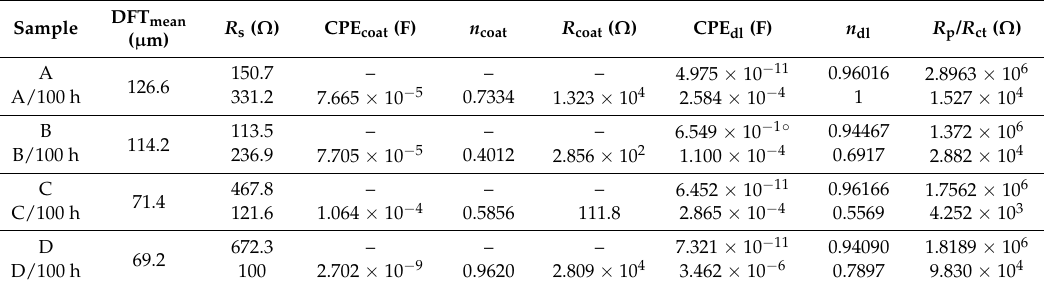
Table 5. The results of the EIS measurement at the begging (A, B, C, D) and after 100 h (A/100 h, B/100 h, C/100 h, D/100 h) immersion in 4% w/w NaOH